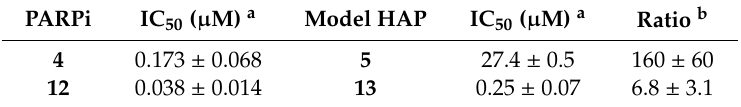
Table 1. Summary of radiometric PARP-1 inhibition data.